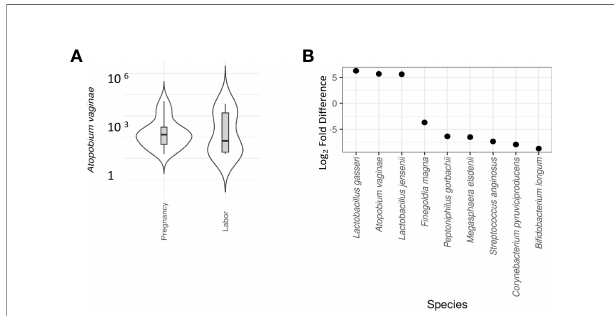
FIGURE 5 | Differential abundance of cervical microbiota between labor and pregnant groups (DeSeq2 test). (A) Violin plot comparison of Atopobium vaginae in pregnancy vs. labor. A vaginae is a Gram-positive bio fi lm-forming anaerobic bacterium of the Coriobacteriaceae family that is held responsible for about 80% of diagnosed cases of bacterial vaginosis. In our samples, a signi fi cantly lower abundance of A vaginae during labor (Log2-fold difference 5.9) was observed. (B) Violin plot comparison of individual taxa revealed that the abundance of nine species was signi fi cantly different between the groups. L. jensenii and L. gasserii as well as Atopobium vaginae were signi fi cantly more abundant (Log2-fold difference 5-6) in the pregnant group in comparison to the labor state ( Table S2 ). To provide a simple overview of the microbiota community types, we categorized the samples into fi ve community state types (CSTs) [47] based on the dominant organisms (CST1: Lactobacillus crispatus , CST2: L. gasseri , CST3: L. iners , CST4: Non- Lactobacillus - dominated microbiota, CST5: L. jensenii . Six non- Lactobacillus species, typical in CST4, were more abundant in active